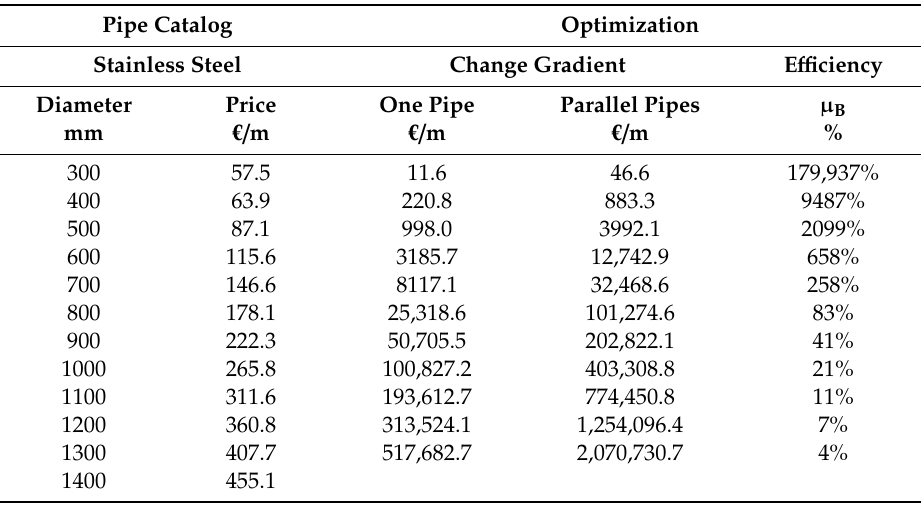
Table 3. Commercial diameter series accompanied by their correspondent price. Change Gradient calculation and optimization process by calculating the required e ffi ciency of the